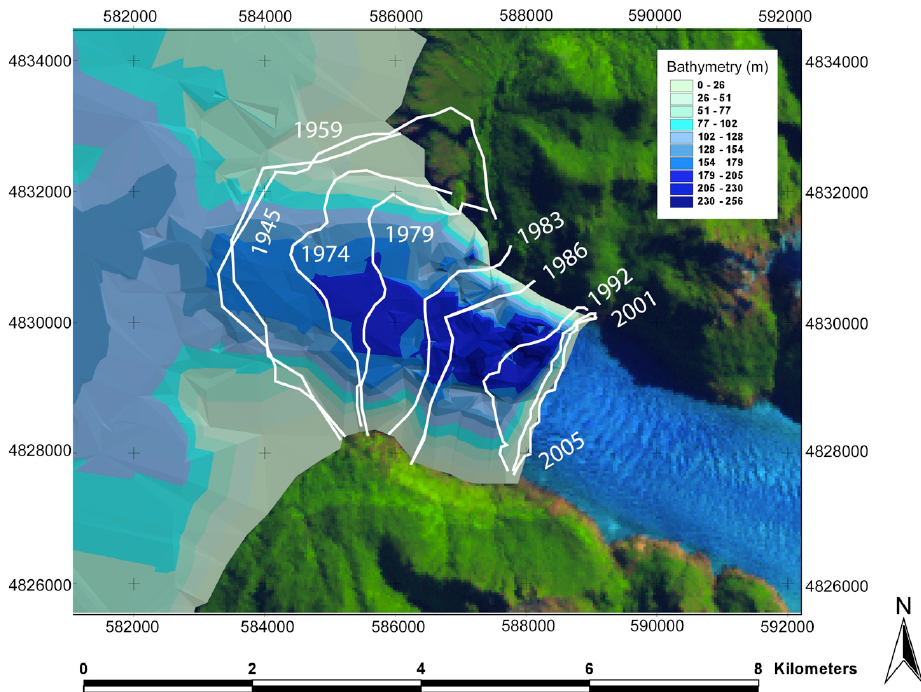
Koppes et al., Mass balance and calving variations from reanalysis data and sparse observations, San Rafael Fig. 3. Terminus positions of Glaciar San Rafael from 1945 to 2006, and bathymetry of Laguna San Rafael. The terminus was relatively stationary between 1945 and 1959, and again between 2001 and 2006. Bathymetry was mapped using ship-board sonar in 2005 and 2006.